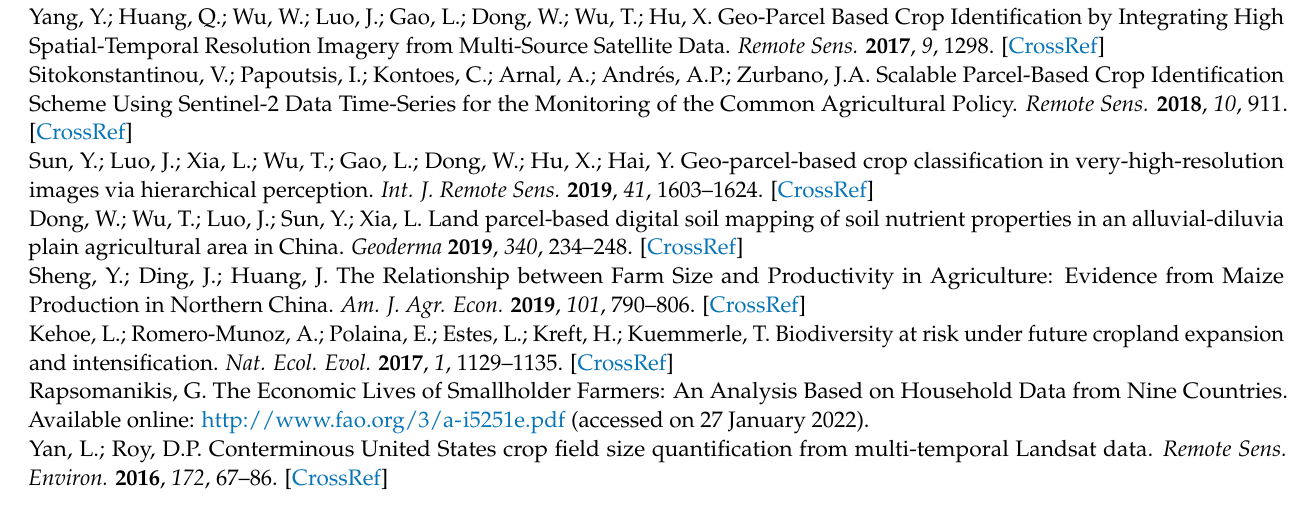
k-means with different clusters numbers; Figure S4: The correlation coefficient between each two texture features; Figure S5: (A) The correlation coefficient between each two co-occurrence shifts, (B) The separability index of Homogeneity feature extracted by different shifts; Figure S6: The relationship between spatial bandwidth and ALV, FOALV and SOALV over the study area; Table S1: The running time of the MSAOS over 8 test